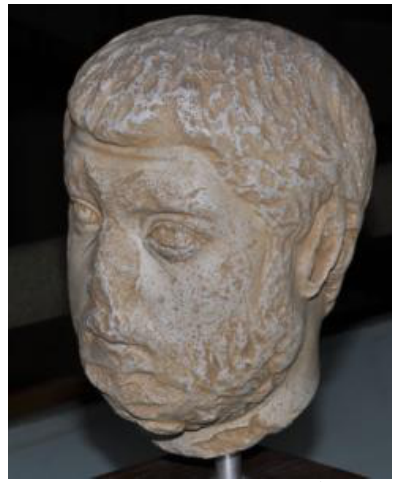
Figure 2. Archaeological